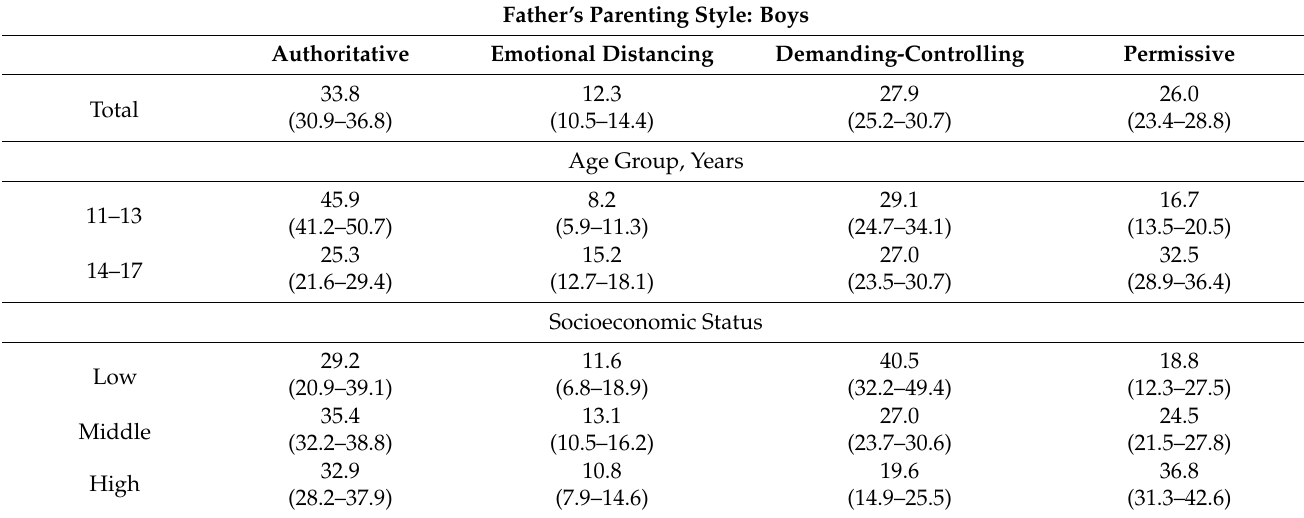
Table 3. Father’s parenting style stratified by children’s age and gender, socioeconomic status, migration status, and family status (weighted prevalence in % and 95% confidence